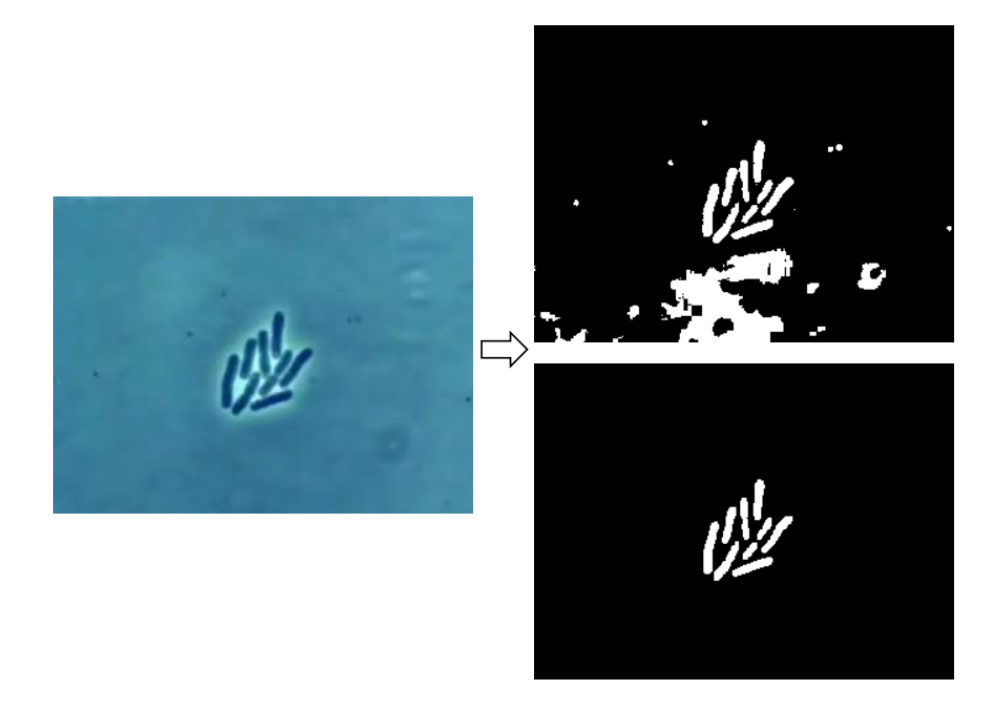
Figure 2. Simple thresholding can result in significant noise as seen in Frame 26 (top right). While Cell Universe has no problem dealing with such levels of noise—even across various choices of threshold—most algorithms we tested against require a much cleaner preprocessed (“segmented”) image such as the one at the bottom right. Video courtesy of YouTube https://www.youtube.com/ watch?v=UccyM8QeIeE (accessed on 1 December